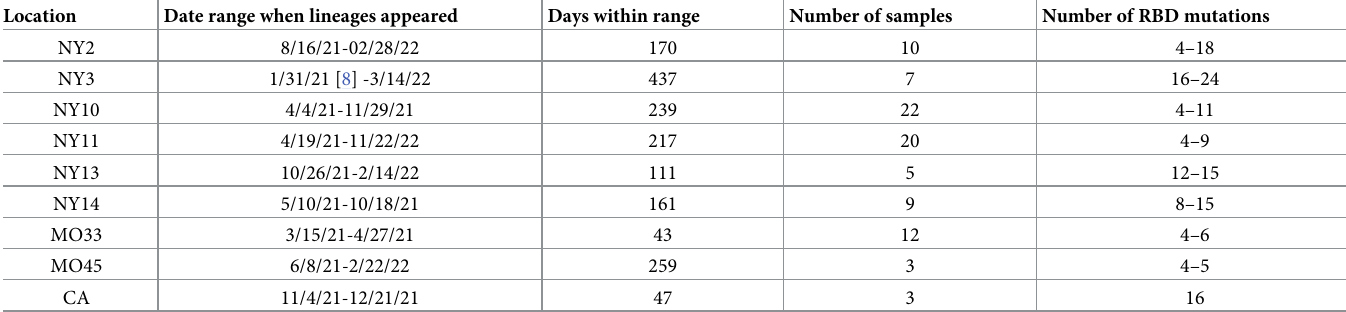
Table 1. Overview of cryptic lineage